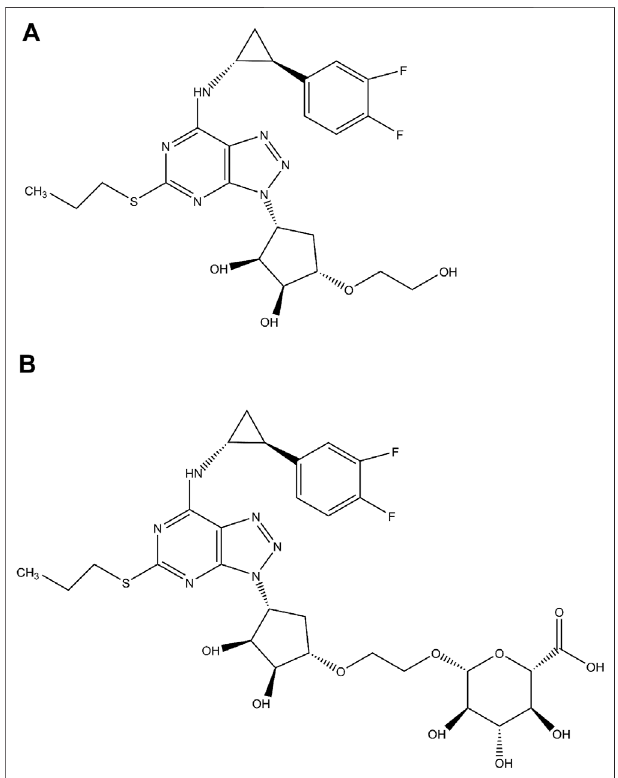
FIGURE1 | The chemical structures of ticagrelor (A) and ticagrelor-O- glucuronide (B)